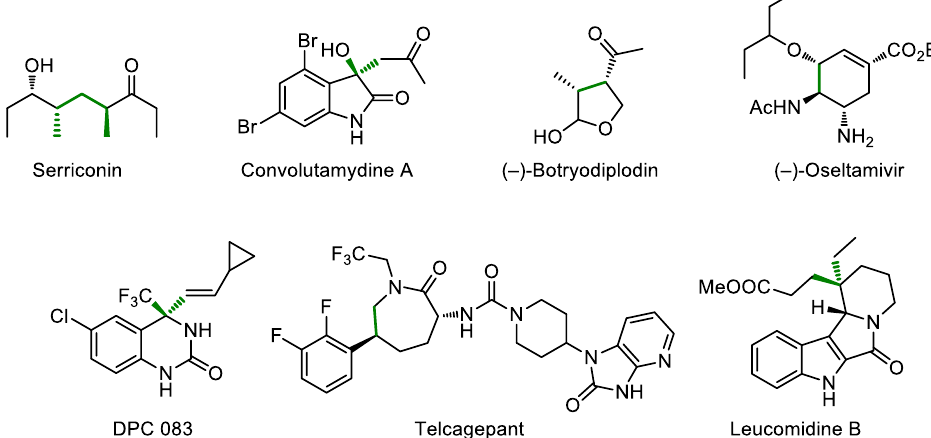
Figure 2. Selected biologically active compounds synthesized using organocatalytic key steps: Serriconin [83], Convolutamydine A [84], (–)-Botryodiplodin [85], (–)-Oseltamivir [86], DPC 083 [87], Telcagepant [88] and Leucomidine B [89]. The bond formed during the organocatalytic step is highlighted in green.